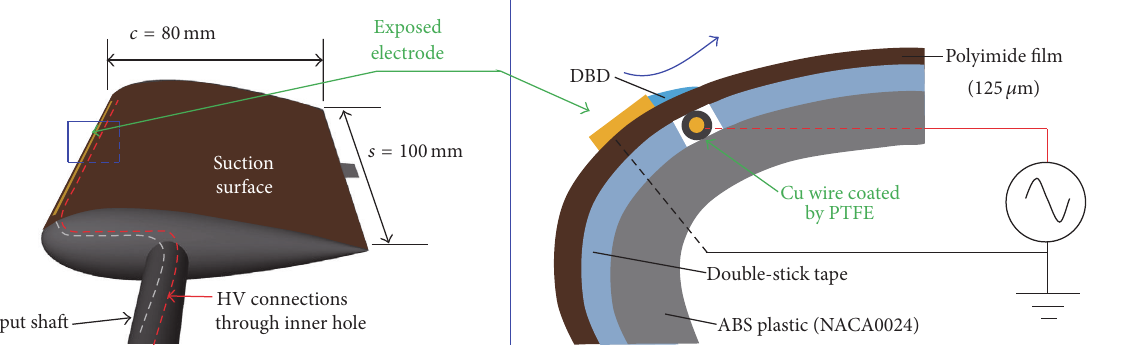
Figure 4: String-type DBD plasma actuator constructed in suction surface near the leading edge of